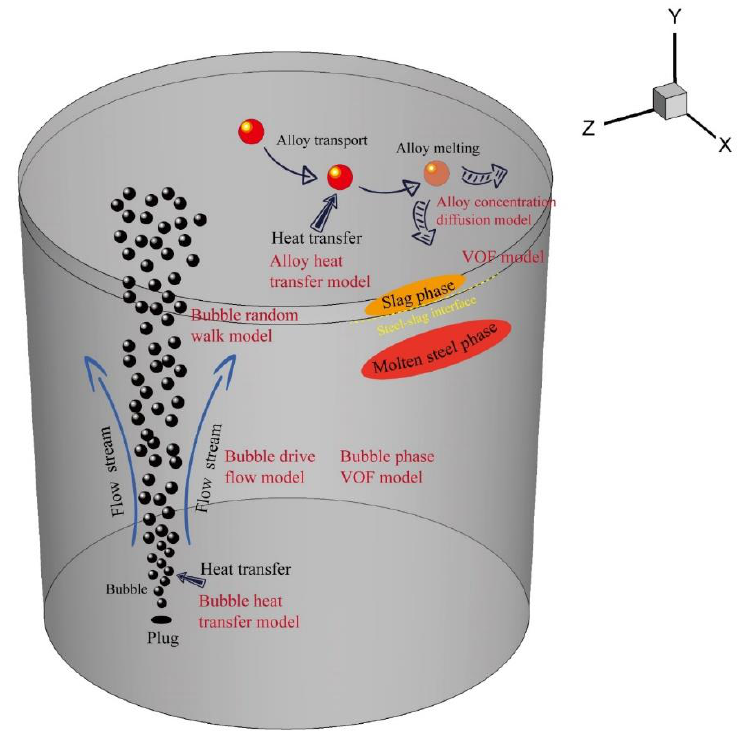
Figure 2. Schematic of the simulation model in the argon-stirred ladle.